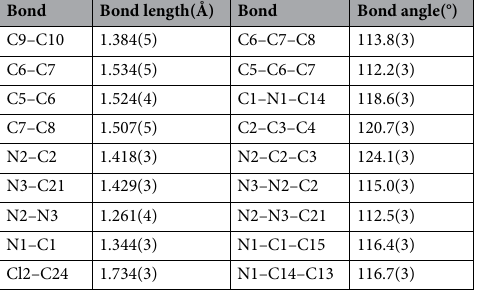
Table 2. Some of the selected bond angles and bond lengths for 4a